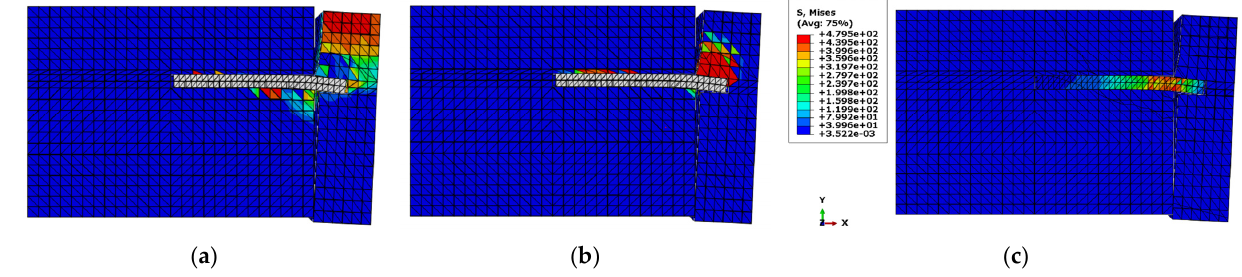
Figure 17. Damage of tension ( a ), of compression ( b ), and Mises stresses ( c ) on the nail for 0°.